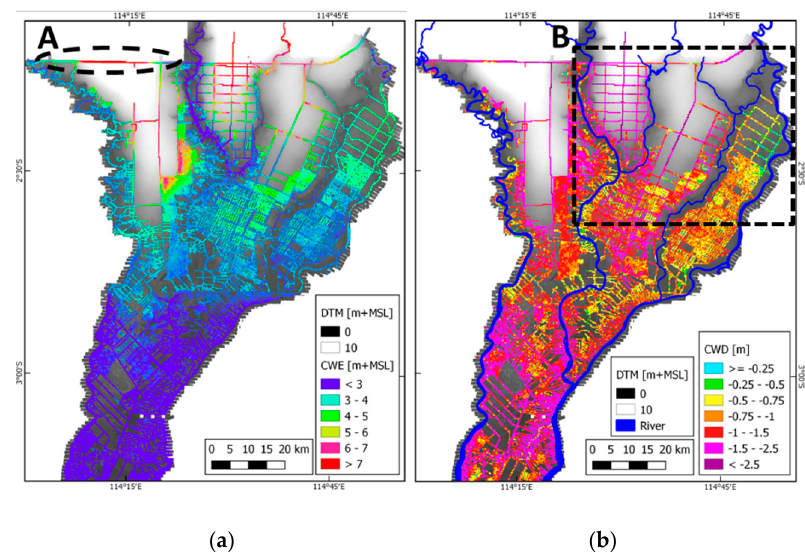
Figure 7. Maps of LiDAR-derived ( a ) canal water surface elevation (CWE) and ( b ) CWD along canals (width >3 m) in the Central Kalimantan study area, as derived from a LiDAR DTM using data collected in the dry season (August–October) of 2011. DTM elevations above ~4 m + mean sea level (MSL) in the northern part of this area indicate the presence of peat domes [21]. Details for areas A and B are provided in Figures 8 and 9. Water 2020 , 12 , x FOR PEER REVIEW